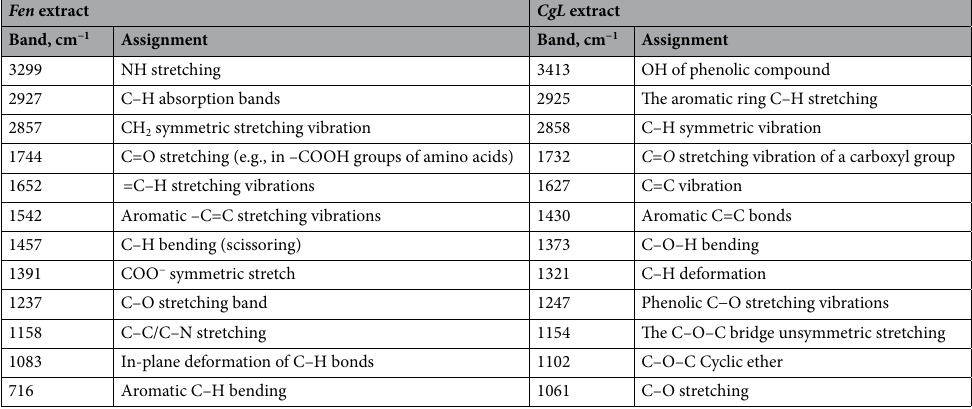
Table 1. FTIR band assignments for Fen and CgL extracts.